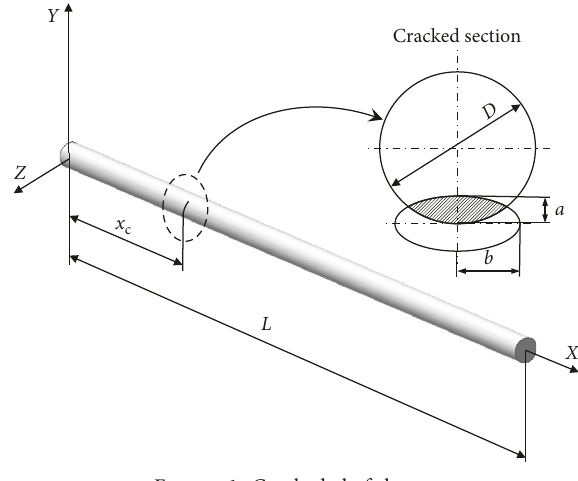
Figure 1: Cracked shaft